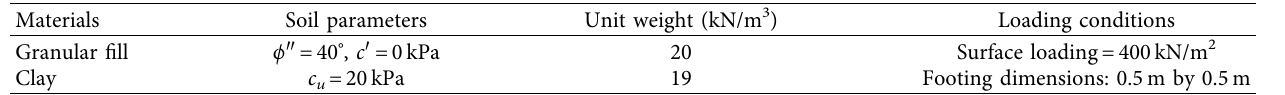
Figure 16: m values versus c u /p o from various studies for (a) unstabilised and (b) geogrid-stabilised granular layer with ϕ ′ and 50 ° . Table 3: Soil parameters and loading